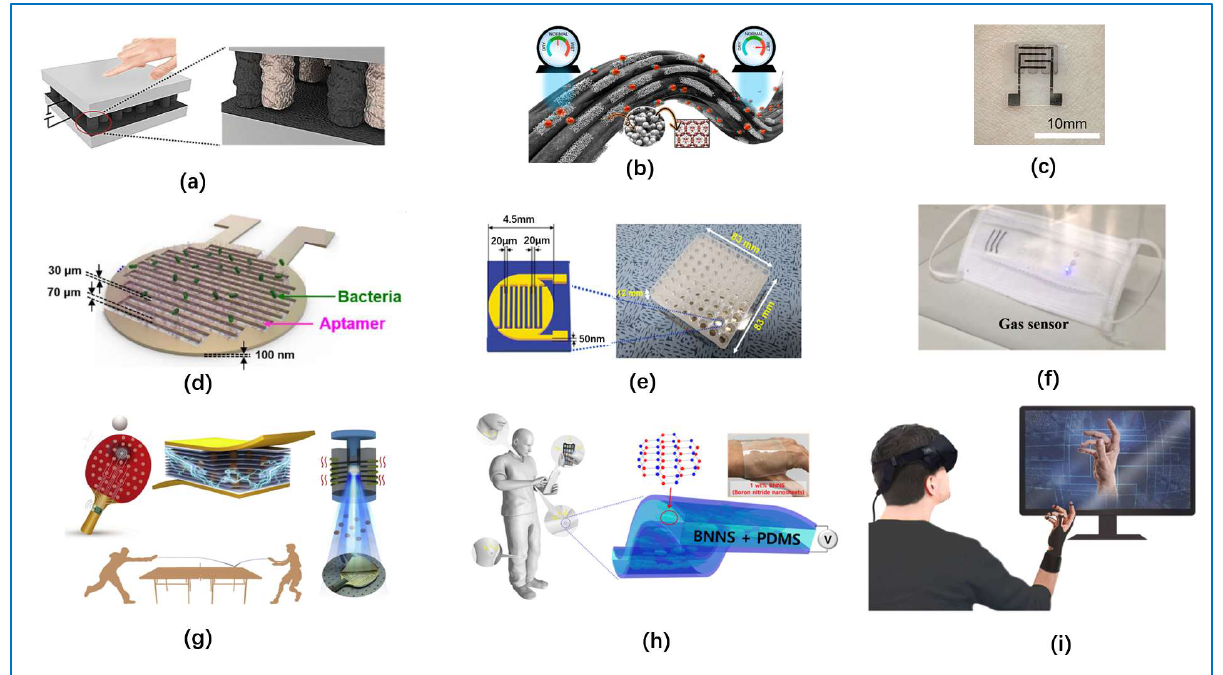
Figure 10. A wide variety of sensors are prepared from conductive fibers. ( a ) Flexible piezoresistive sensor based on interlocking graphene microarray, ( b ) a humidity sensor prepared using a metal- organic framework (MOF) and a fiber fabric, ( c ) photography of temperature sensor attached on skin, ( d ) schematic of aptamer-functionalized capacitance sensor, ( e ) schematic of aptamer-functionalized capacitance sensor, ( f ) a multi-functional face mask with integrated fiber gas sensors, ( g ) piezoelectric sensor made into sports training system, ( h ) transparent and flexible piezoelectric human motion sensor, ( i ) a glove for user–VR interaction (piezoelectric sensor) [158–166].